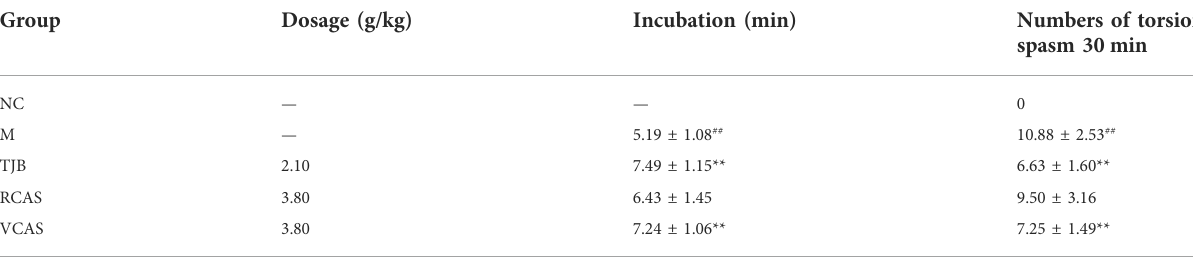
TABLE 1 Writhing response of each group during the experiment ( (cid:1) x ± s, n = 8).